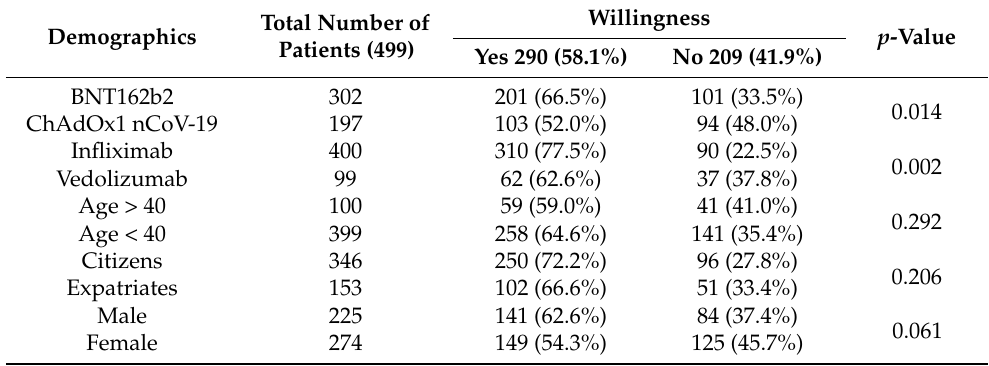
Table 2. Demographics of patients with IBD according to willingness to receive the booster